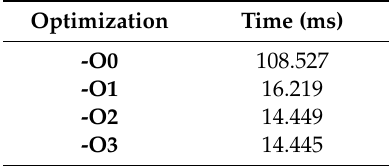
Table 6. Running time at different optimization levels.